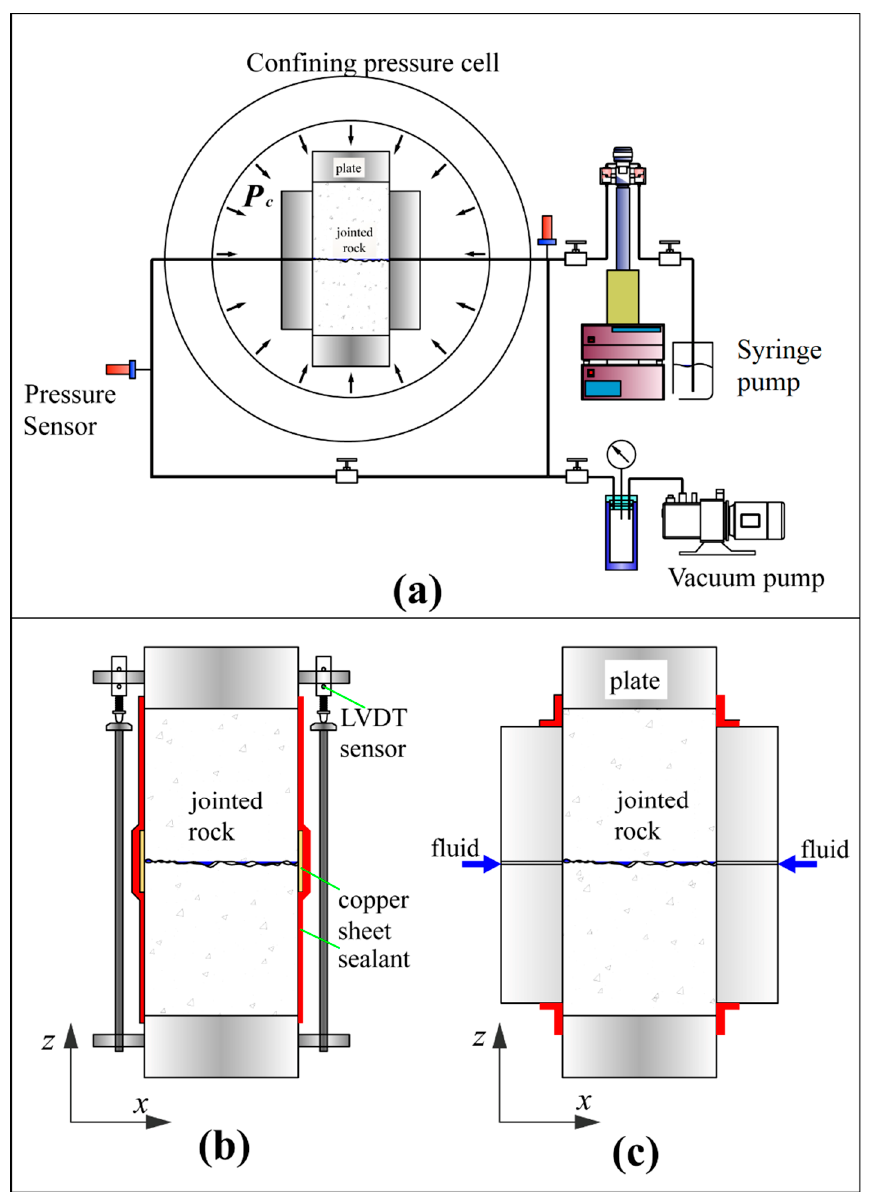
Figure 2. Schematic diagram of hydrostatic compression and injection test of joint. ( a ) Diagram of test system; ( b ) Left view of tested sample; ( c ) Front view of tested sample.